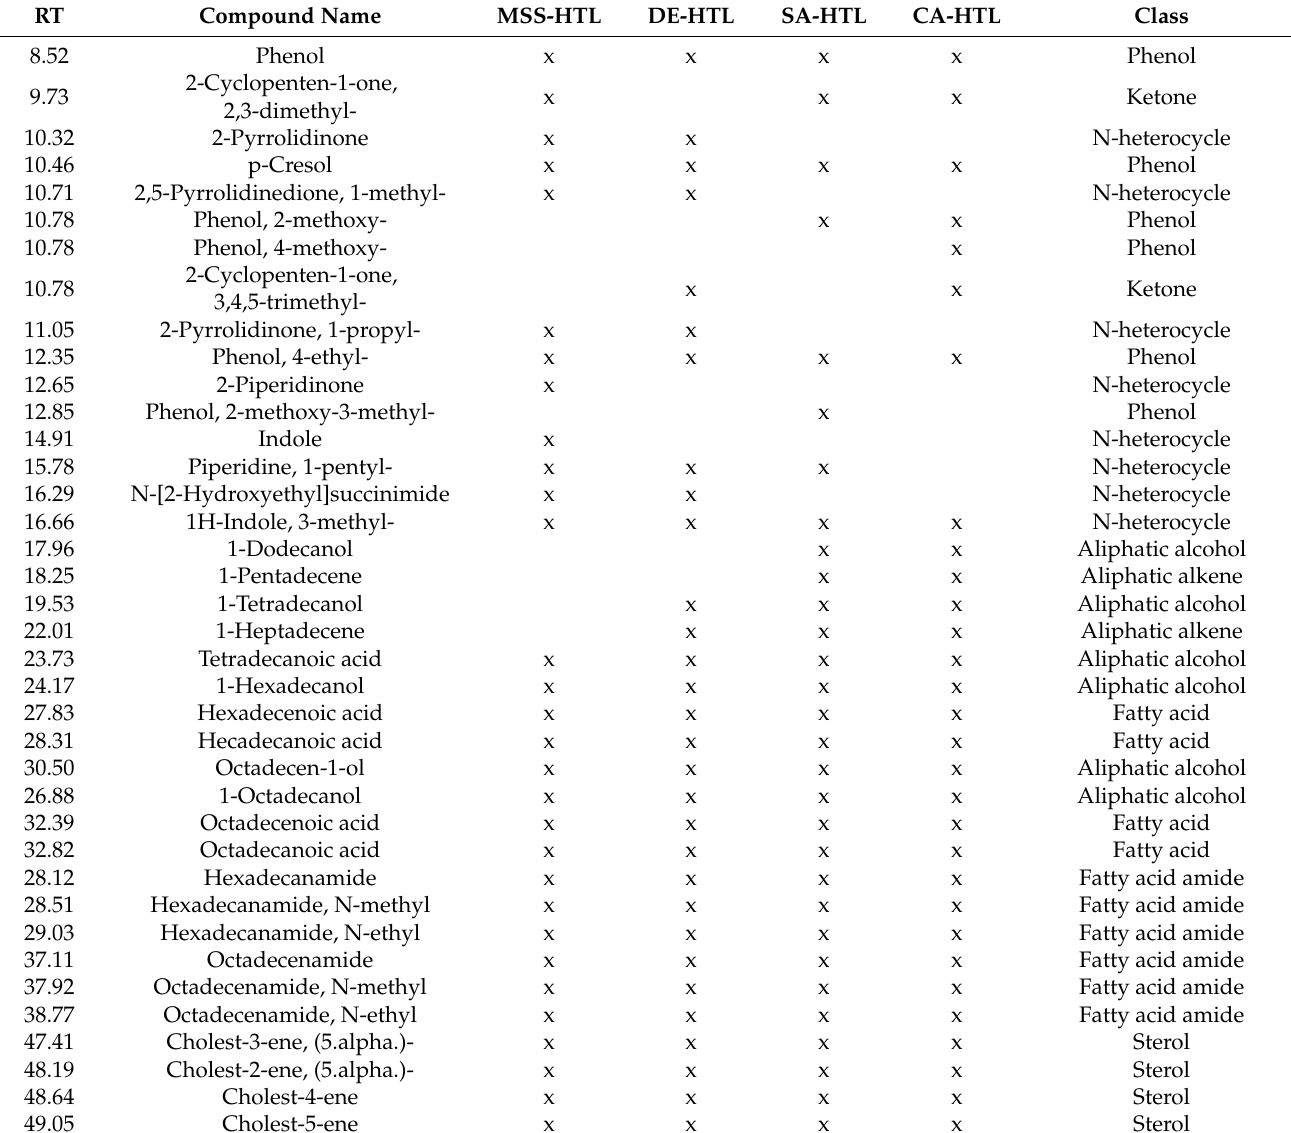
Table 3. Major compounds of the GC-MS total ion chromatogram areas of biocrude samples from liquefied municipal sewage sludge and pre-treated